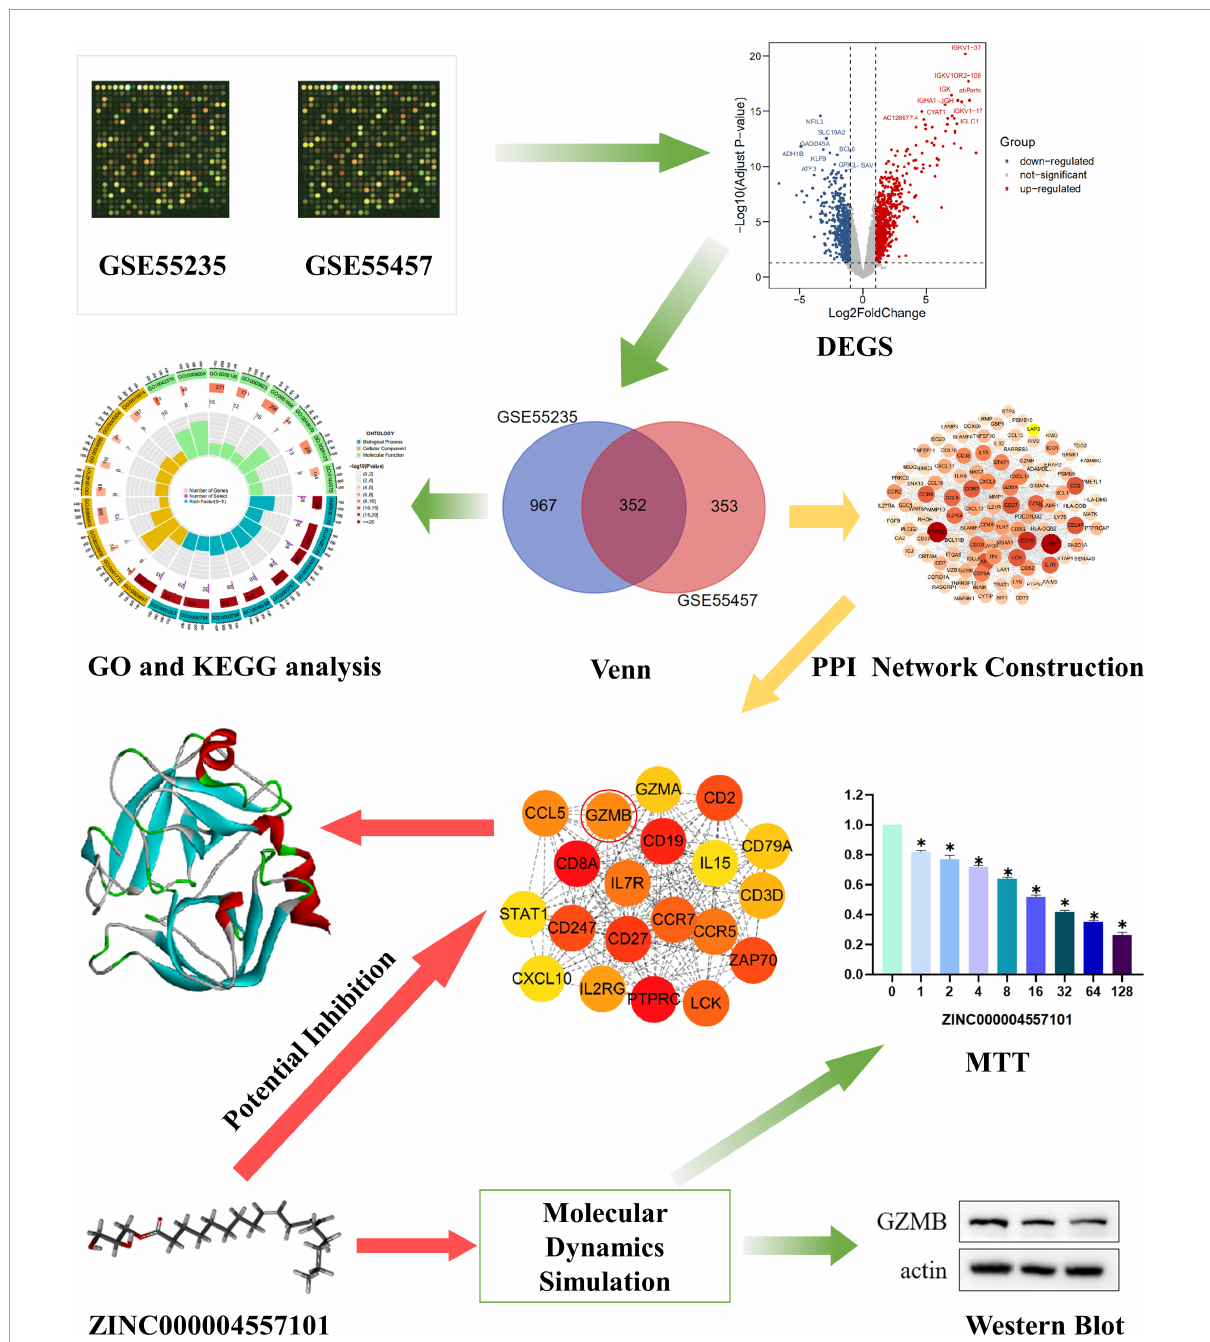
FIGURE1 Research framework. The first set of images was chosen to represent the tissue dataset from the Gene Expression Comprehensive